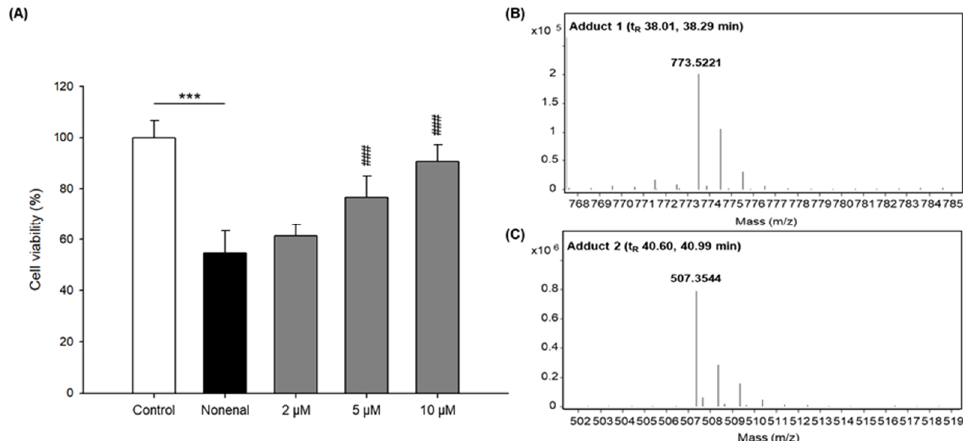
Figure 3. ( A ) Effects of KB with trans -2-nonenal on the cell viability of human keratinocytes and MS spectra of trans -2-nonenal adducts of ( B ) KB and ( C ) feruloylputrescine. Cell viability of human keratinocytes treated with trans -2-nonenal (150 μM) and KB (2, 5, 10 μM). These data are expressed as mean ± SD of three independent experiments. *** p < 0.0001 vs. control; ### p < 0.0001 vs. trans -2-nonenal.